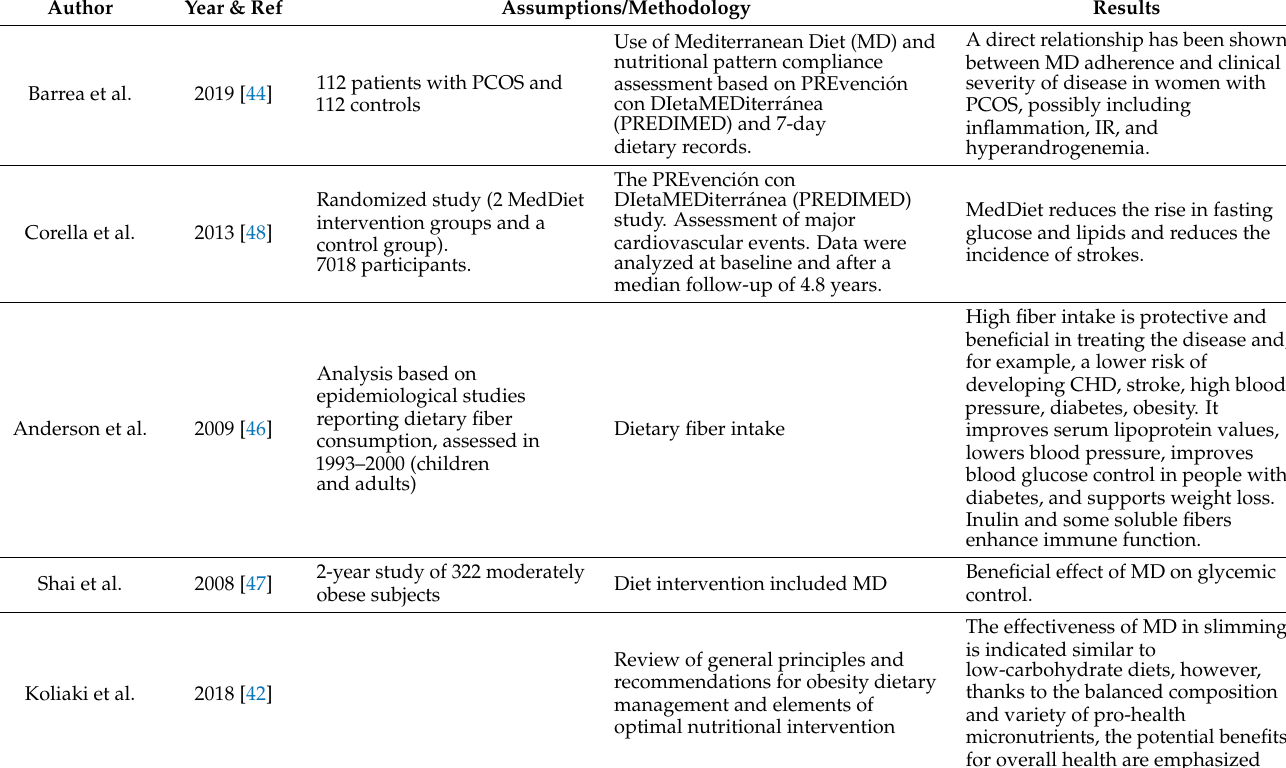
Table 1. Effects of a Mediterranean Diet